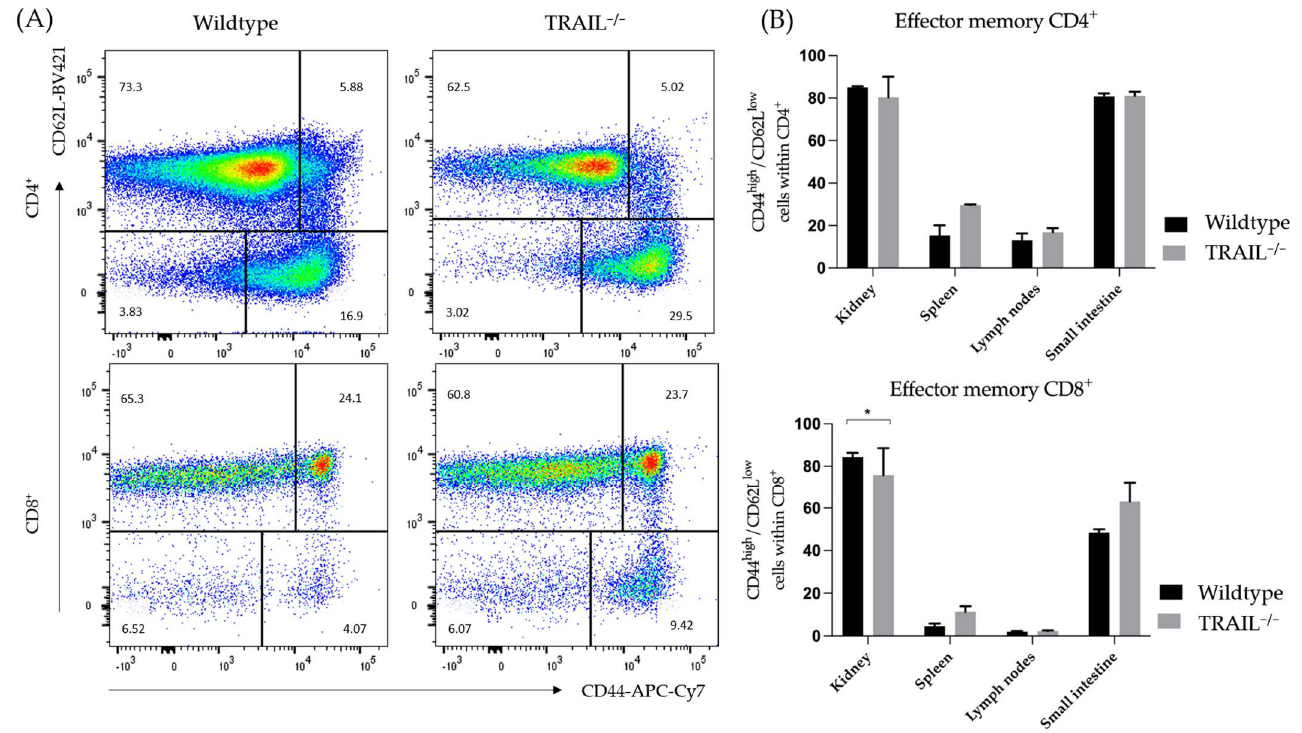
Figure 7. ( A ) Exemplary dot plot represents the presence of effector memory CD62 low CD44 high cells within the CD4 + and CD8 + population in the spleen of TRAIL −/− mice versus wildtype C57BL/6 mice. ( B ) Histogram compares means ± SEM of effector memory CD62 low CD44 high cells within the CD4 + resp. CD8 + population in the spleen, lymph nodes, kidney, and small intestine of TRAIL −/− mice versus wildtype C57BL/6 mice ( t -test, n = 6 per group, * p < 0.05).